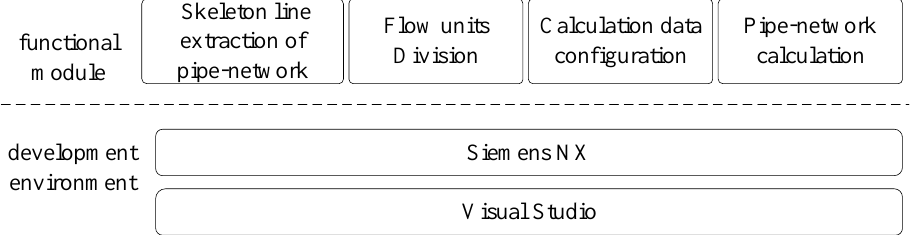
Figure 30. Architecture design of blade data extraction system for PNC.